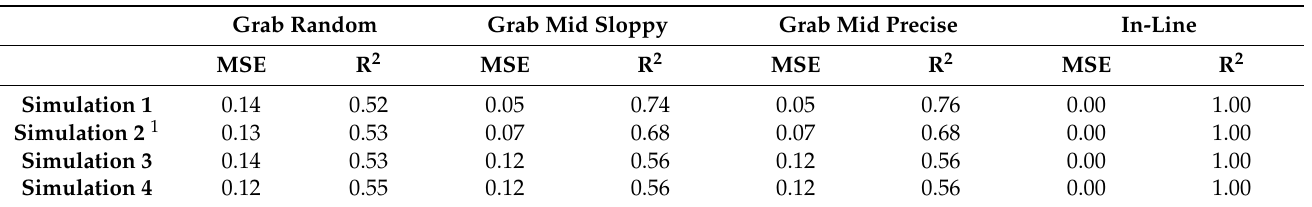
Table 3. Precision of batch mean estimates for different sampling regimes, evaluated by mean squared error (MSE) and R 2 .